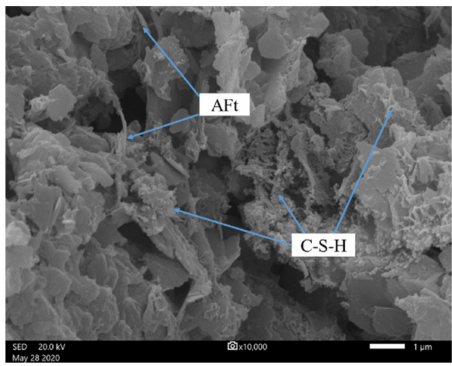
Figure 6. SEM micrograph of CPB with cement.